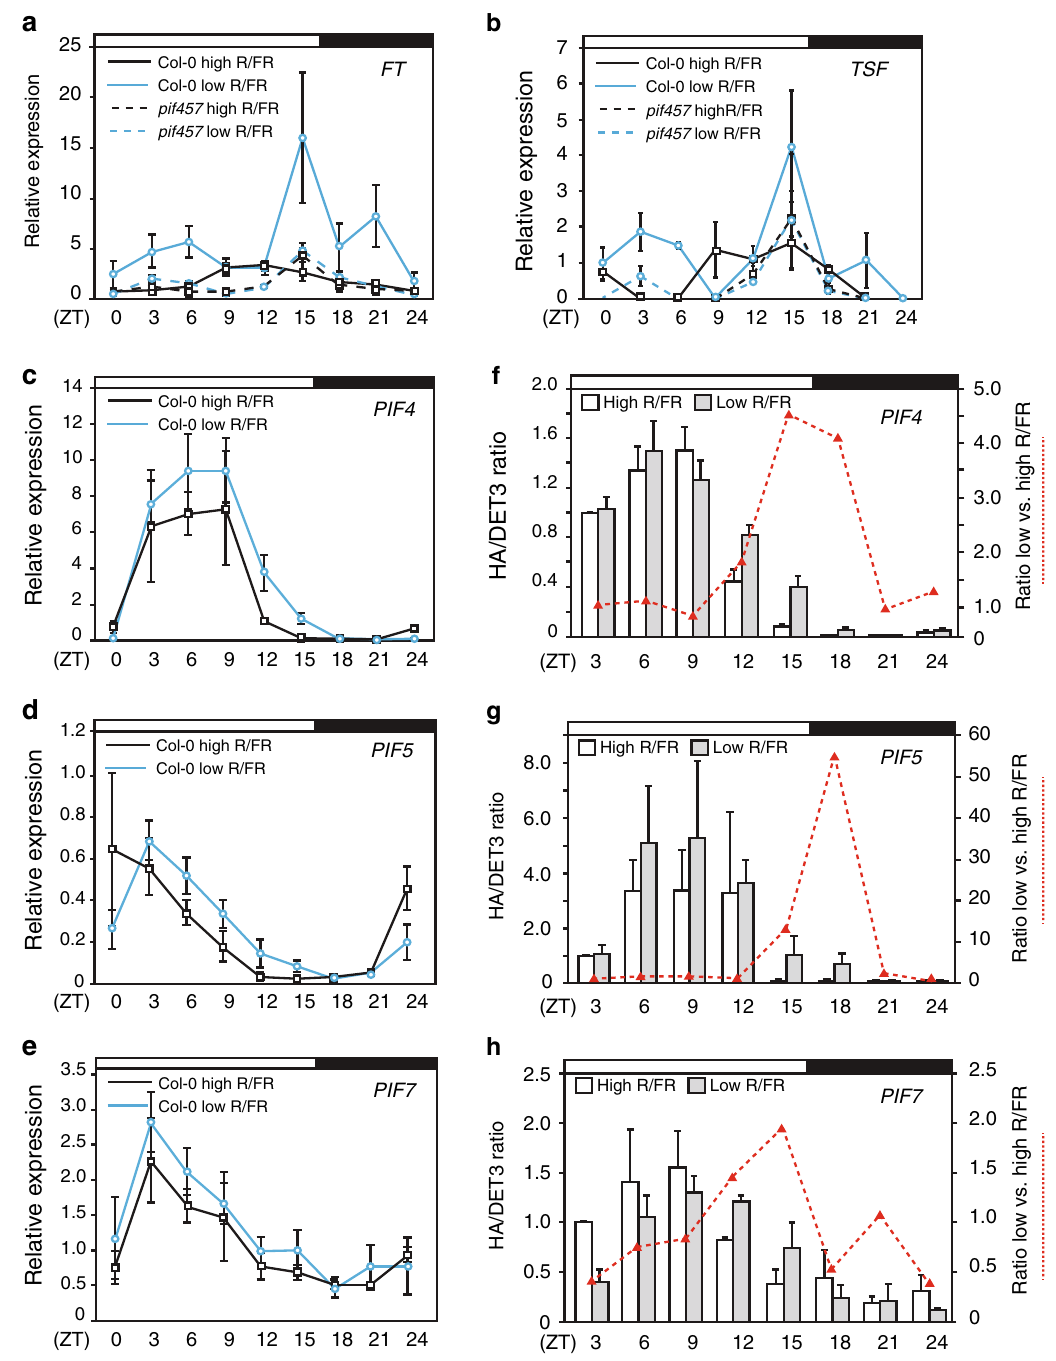
Fig. 3 PHYTOCHROME-INTERACTING FACTORS (PIFs) and FLOWERING LOCUS/TWIN SISTER of FT ( FT/TSF ) expression pattern in high and low red/far- red (R/FR) ratio. Diel time course of FT ( a ), TSF ( b ), PIF4 ( c ), PIF5 ( d ), and PIF7 ( e ) over 24 h harvested every 3 h. Expression levels were determined using quantitative real-time PCR (qRT-PCR) using three biological replicates and three technical replicates of 10 – 11-day-old Col-0 and pif4pif5pif7 mutant. Plants were grown under high R/FR for 5 days and either kept in the same condition of shifted to low R/FR on day 6. White and dark bars on top of each chart correspond to light and dark phases, respectively. Error bars correspond to 2× standard error. Protein accumulation of pif4-101/pPIF4::PIF4-3HA ( f ), pif5-3/pPIF5::PIF5-3HA ( g ), and pif7-2/pPIF7::PIF7-3HA ( h ) in 10 – 11-day-old plants harvested every 3 h. White (high R/FR) and gray (low R/FR) bars correspond to the average protein levels of three biological replicates and at least two technical replicates relative to DET3. Red dashed lines represent the PIF protein level ratio of low/high R/FR. Error bars represent standard deviation and white and black bars on top of each chart represent the light and dark phases,